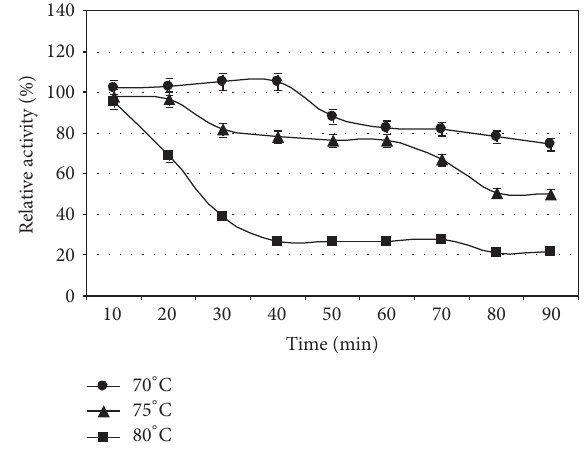
-amylase enzyme 𝛼𝛼